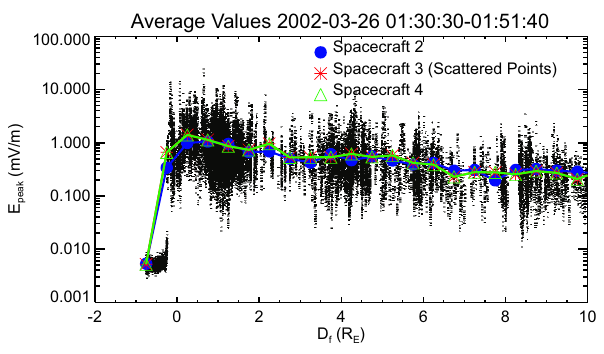
Fig. 3. Dependence of the WBD receiver electric field amplitudes on D f for 26 March 2002 between 01:30:30–01:51:40 UT. The scat- tered points represent the maximum electric fields in 0.5ms win- dows of each 5-ms waveform snapshot for spacecraft 3, and the red line represents the average electric field amplitudes in 0.5 R E bins of the D f coordinate for spacecraft 3. The blue and green lines rep- resent the average amplitudes for spacecraft 2 and